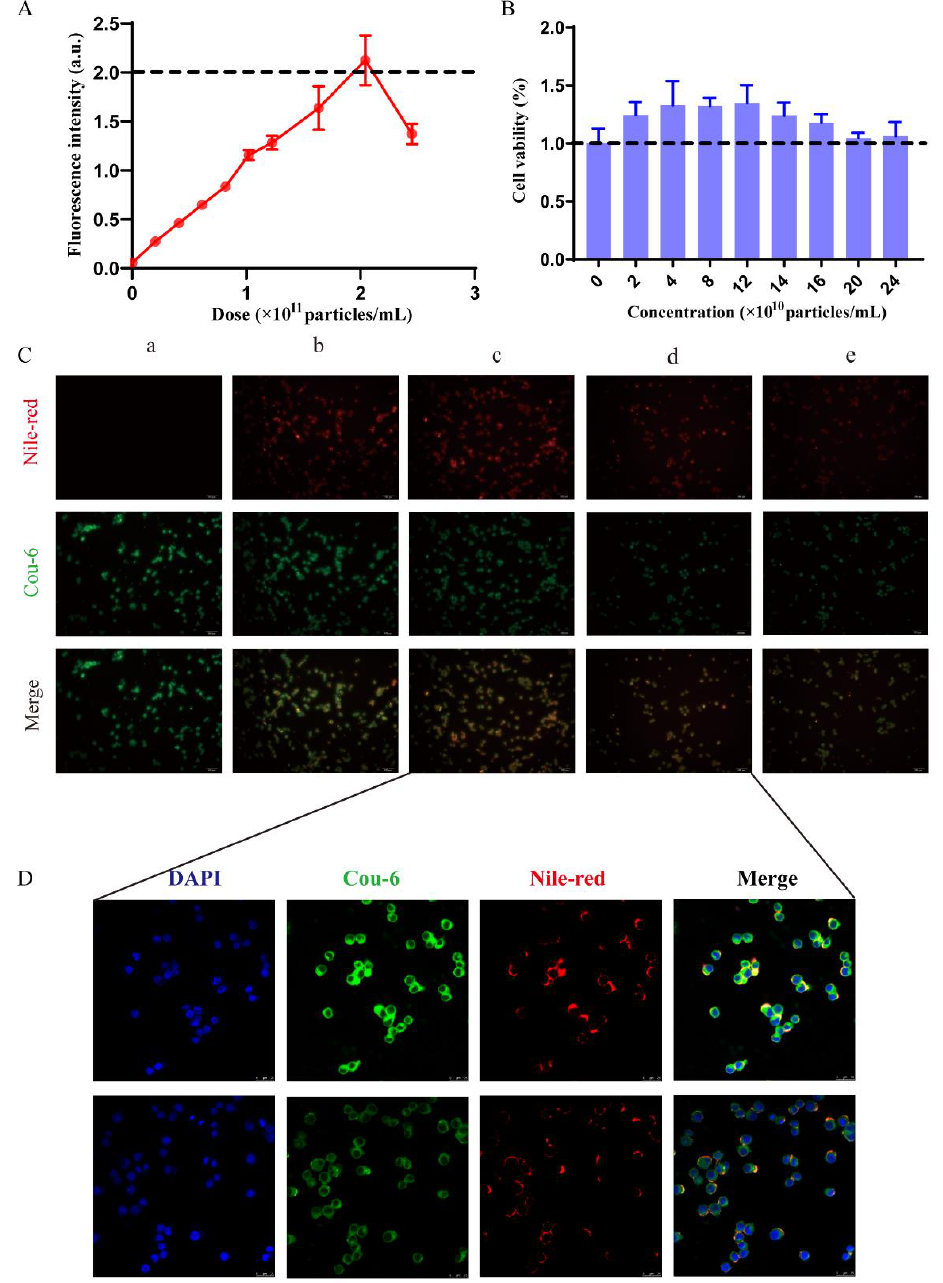
Figure 2. Characterization of threshold in vitro. ( A ) Fluorescence intensity thresholds after 4 h of fluorescent nanoparticle uptake by RAW264.7 cells ( n = 5). ( B ) CCK-8 assay detects changes in the cell viability of RAW264.7 cells after 4 h of BSA nanoparticle uptake ( n = 4). ( C ) Representative fluorescence microscopy (FM) images of the saturation of cellular uptake in RAW264.7 cells ( n = 3). The five concentrations of Nile-red-labeled BSA nanoparticles are a = 0 × 10 11 particles/mL, b = 1 × 10 11 particles/mL, c = 2 × 10 11 particles/mL, d = 2.2 × 10 11 particles/mL, and e = 2.4 × 10 11 particles/mL. The concentration of coumarin-6-labeled BSA nanoparti- cles is 1 × 10 11 particles/mL. ( D ) Representative confocal laser scanning microscopy (CLSM) images of nanoparticles distribution in RAW264.7 cells during the saturation of cellular